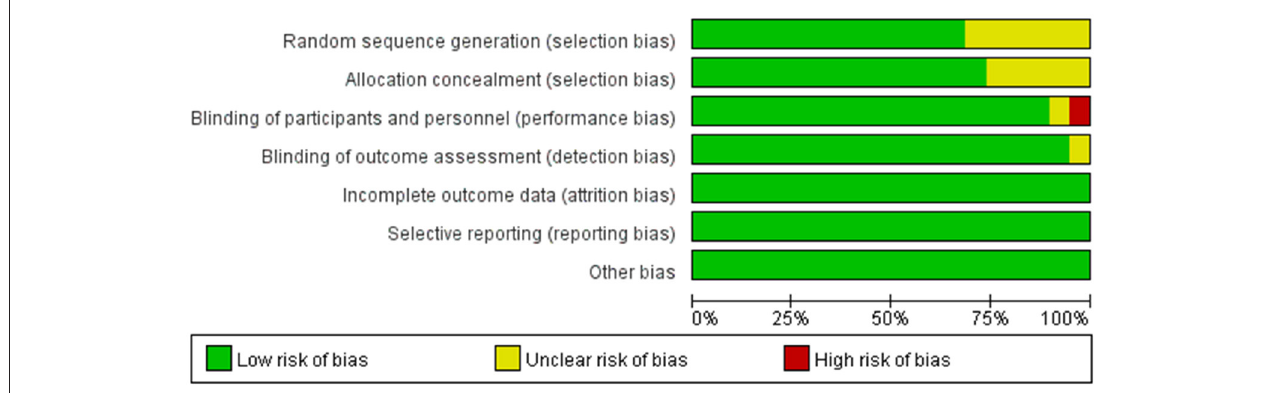
FIGURE 2 | Quality of included studies. The overall quality of the selected studies was assessed by the Cochrane Collaboration